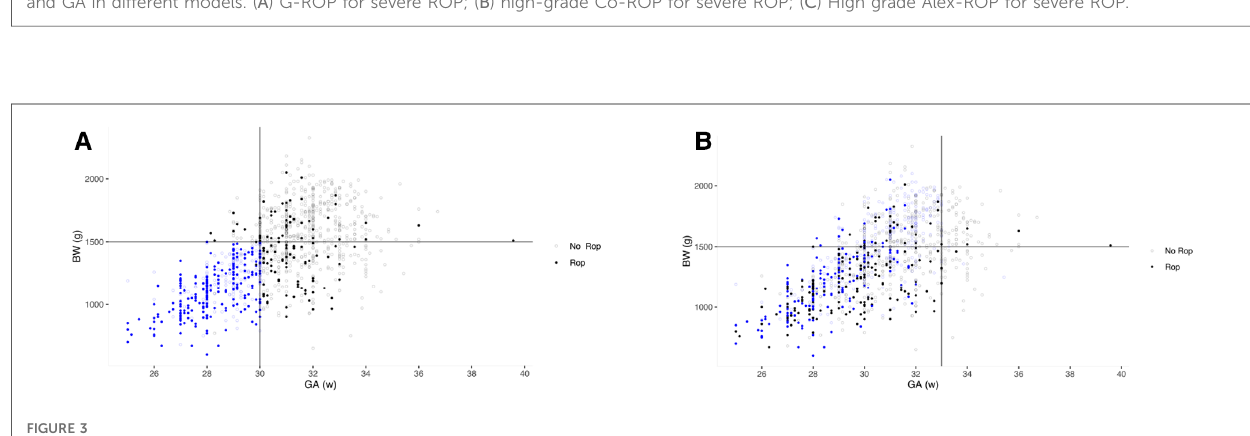
Our study validated 4 ROP prediction models based on postnatal weight gain in the Chinese population. Two models were developed in North America (G-ROP and CO-ROP). The other two models were established by developing countries (Brazil and Egypt). The different performance of the four models was revealed in our study.